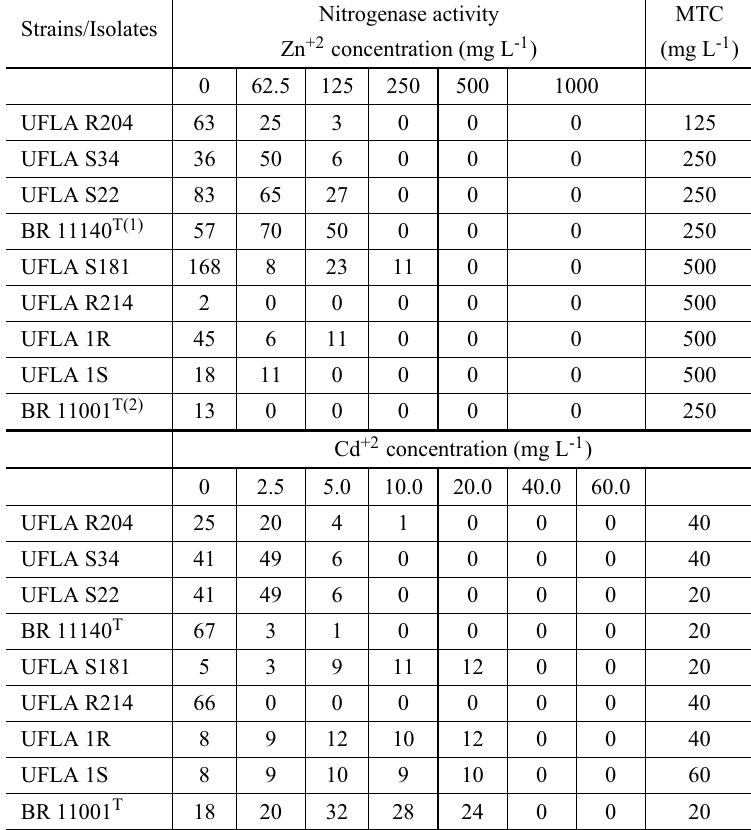
Nitrogenase activity (acetylene reduction: nmoles ethylene/culture/hour) measured four days after inoculation by Azospirillum spp. cultures and Maximum Tolerated concentration (MTC) for growth measured by pellicle formation ten days after inoculation in media supplemented with increasing concentrations of Zn +2 (Zn SO 4 .7H 2 O) or with Cd +2 (Cd SO 4 .8H 2 O). Nitrogenase Strains/Isolates